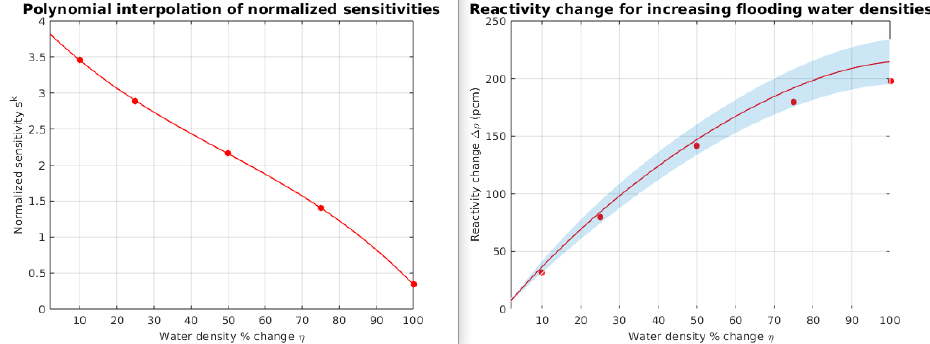
Figure 3: Central channel flooding